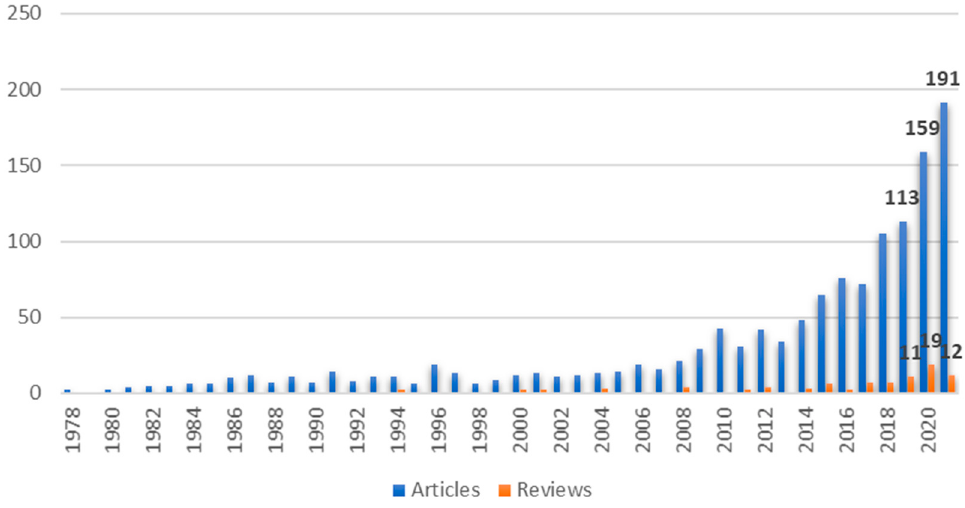
Figure 2. Annual scientific production.